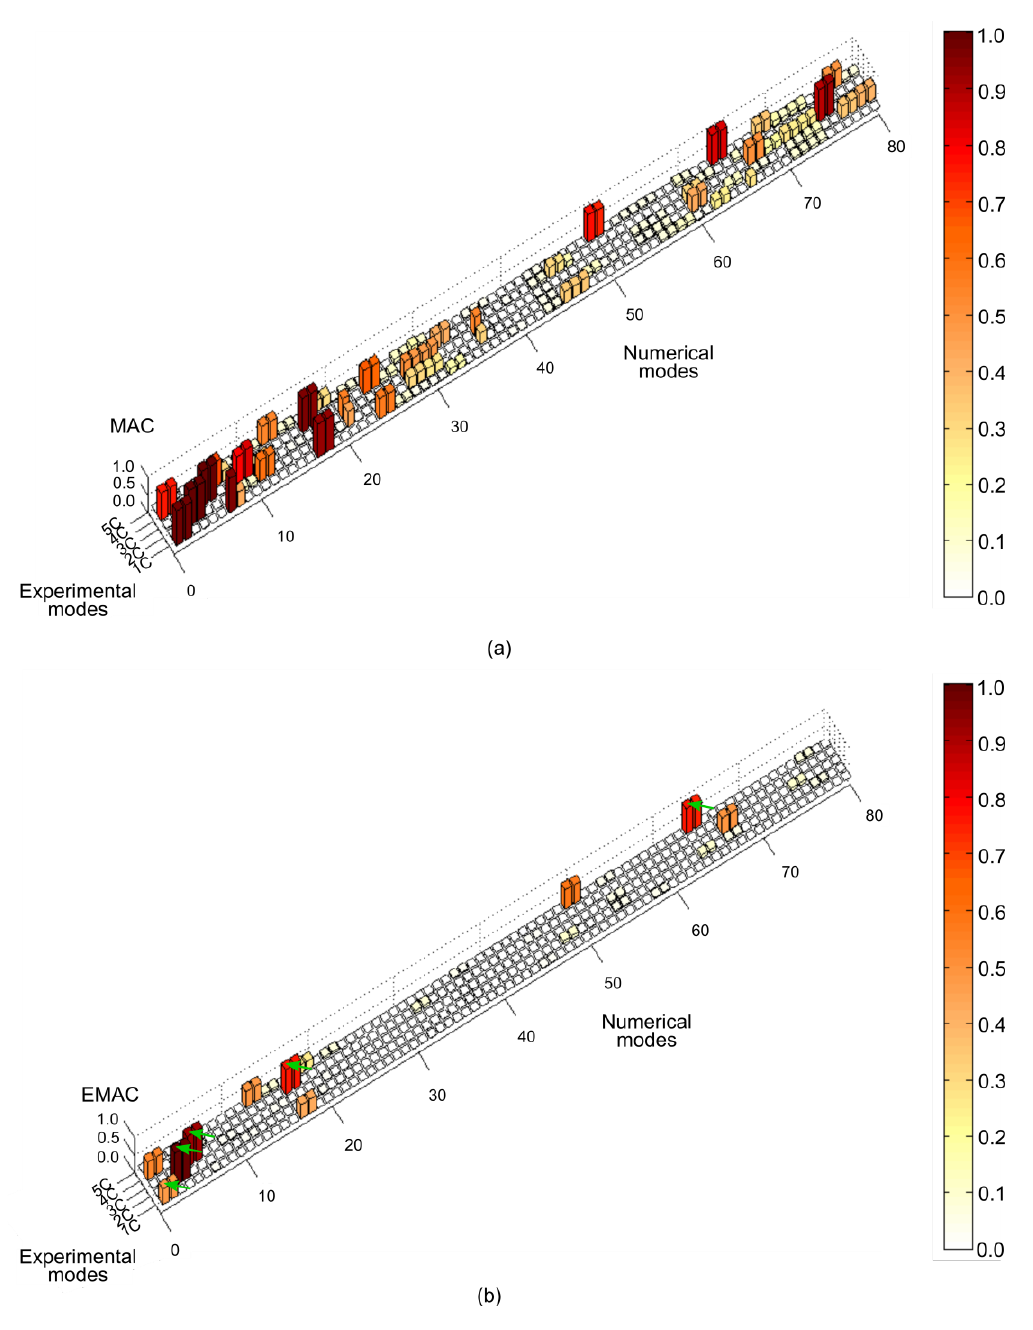
Figure 10. Pairing of experimental and numerical modes of the BBN vehicle based on the ( a ) MAC and ( b ) EMAC parameters.